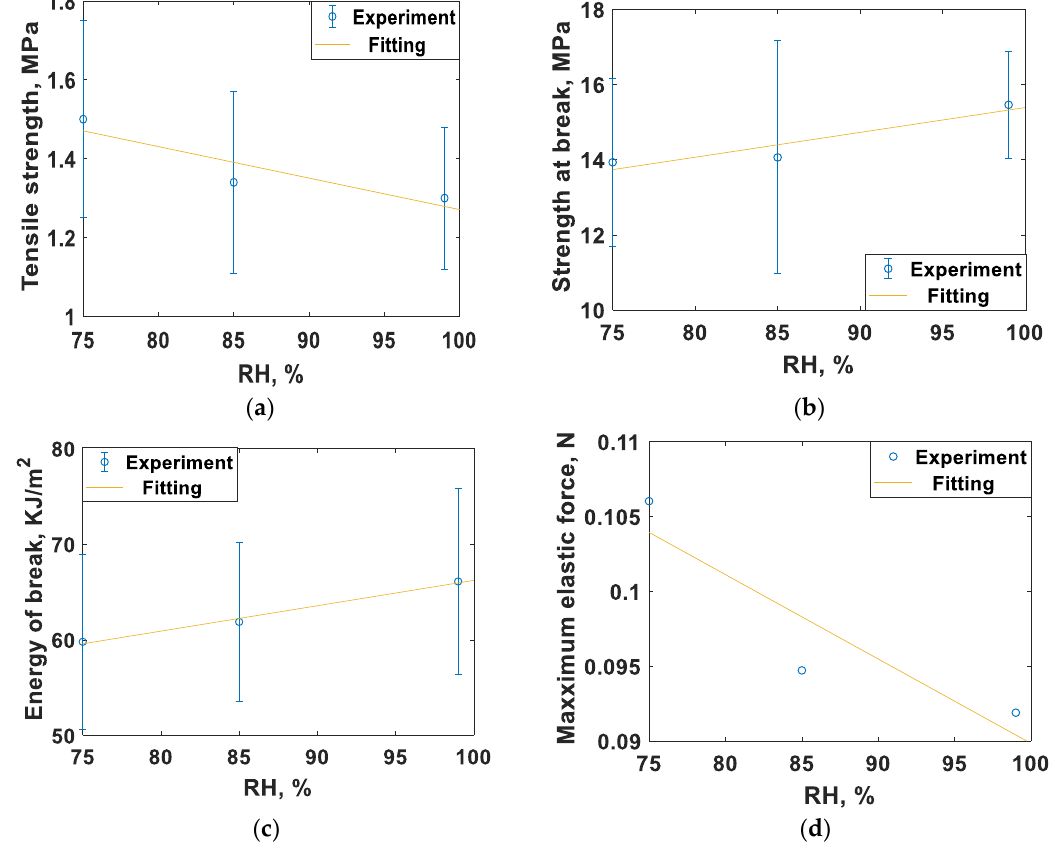
Figure 9. Change of mechanical properties at relatively high levels of humidity. The mechanical properties are ( a ) tensile strength, ( b ) strength at break, ( c ) energy of break, and ( d ) maximum elastic force.